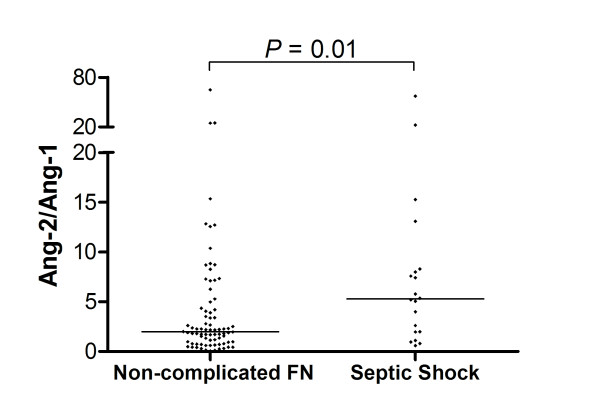
Ang-2/Ang-1 ratio in FN patients. Angiopoietin- (Ang)-2/Ang-1 ratio in patients with non-complicated febrile neutropenia (FN) (n = 79) or septic shock (n = 20). Horizontal bars represent median values; Mann-Whitney test.